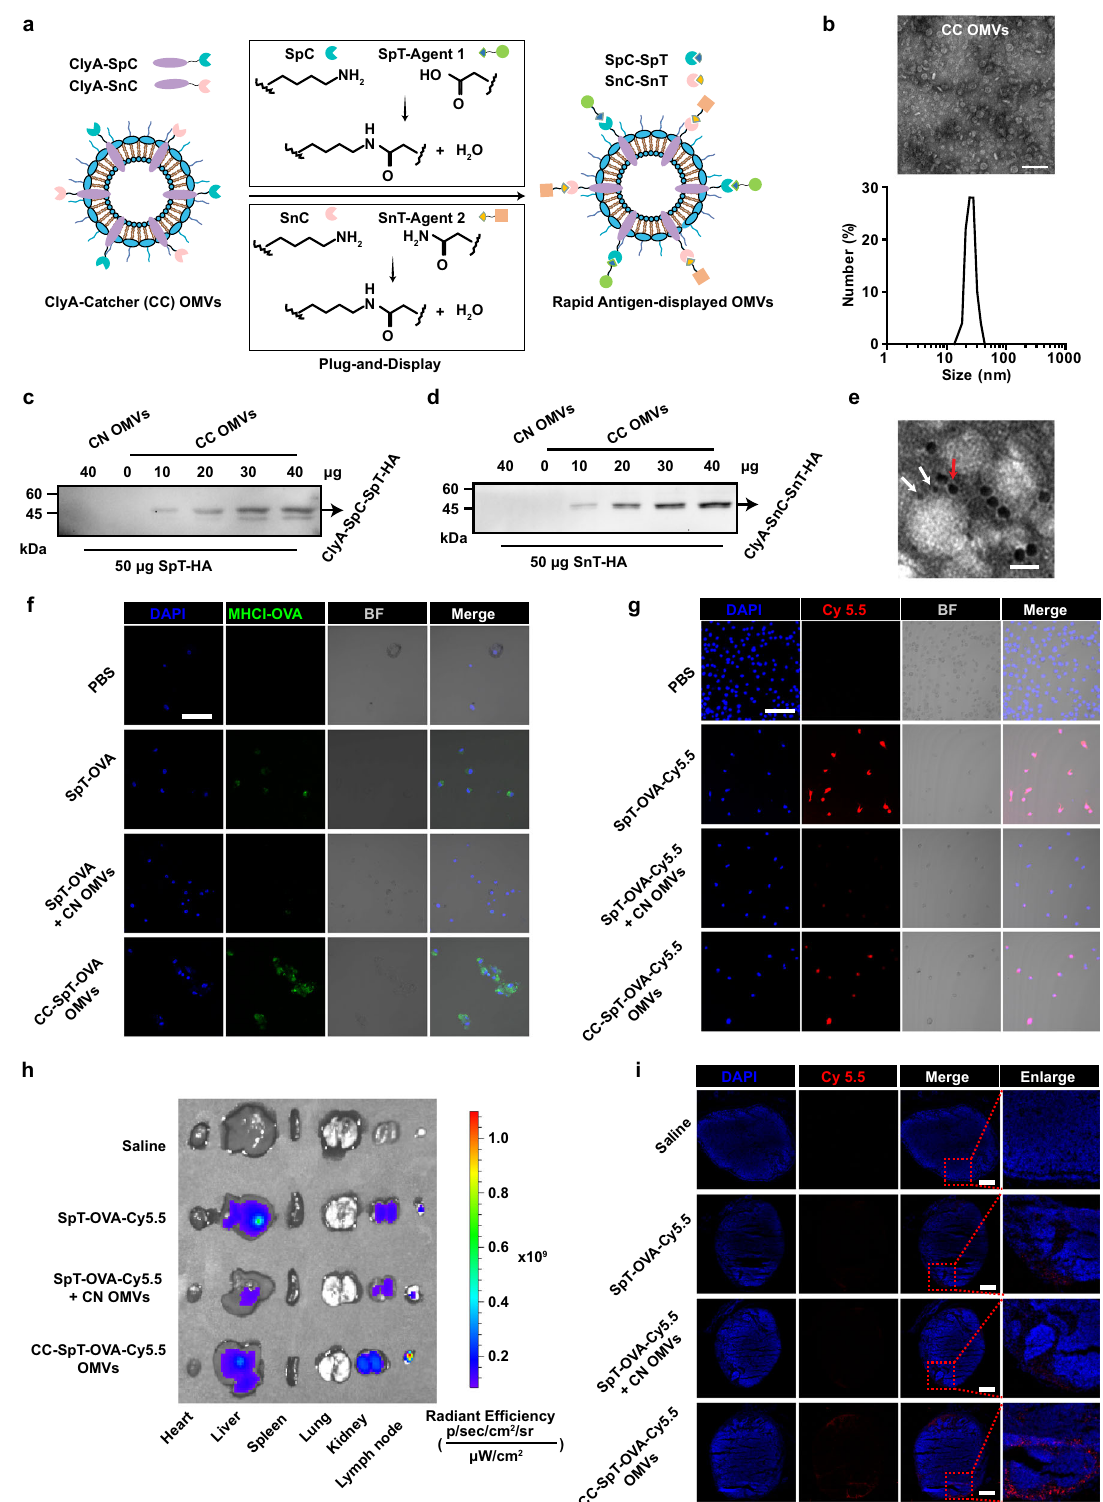
post injection. Strong fl uorescence was observed in the liver at 6 h, but this declined by 12 h. However, there was a clear accumulation of fl uorescence in the lymph nodes at 12 h (Fig. 3h). At this time point, the lymph nodes were sectioned and examined by fl uorescence microscopy. Only when the antigen was conjugated to CC OMVs